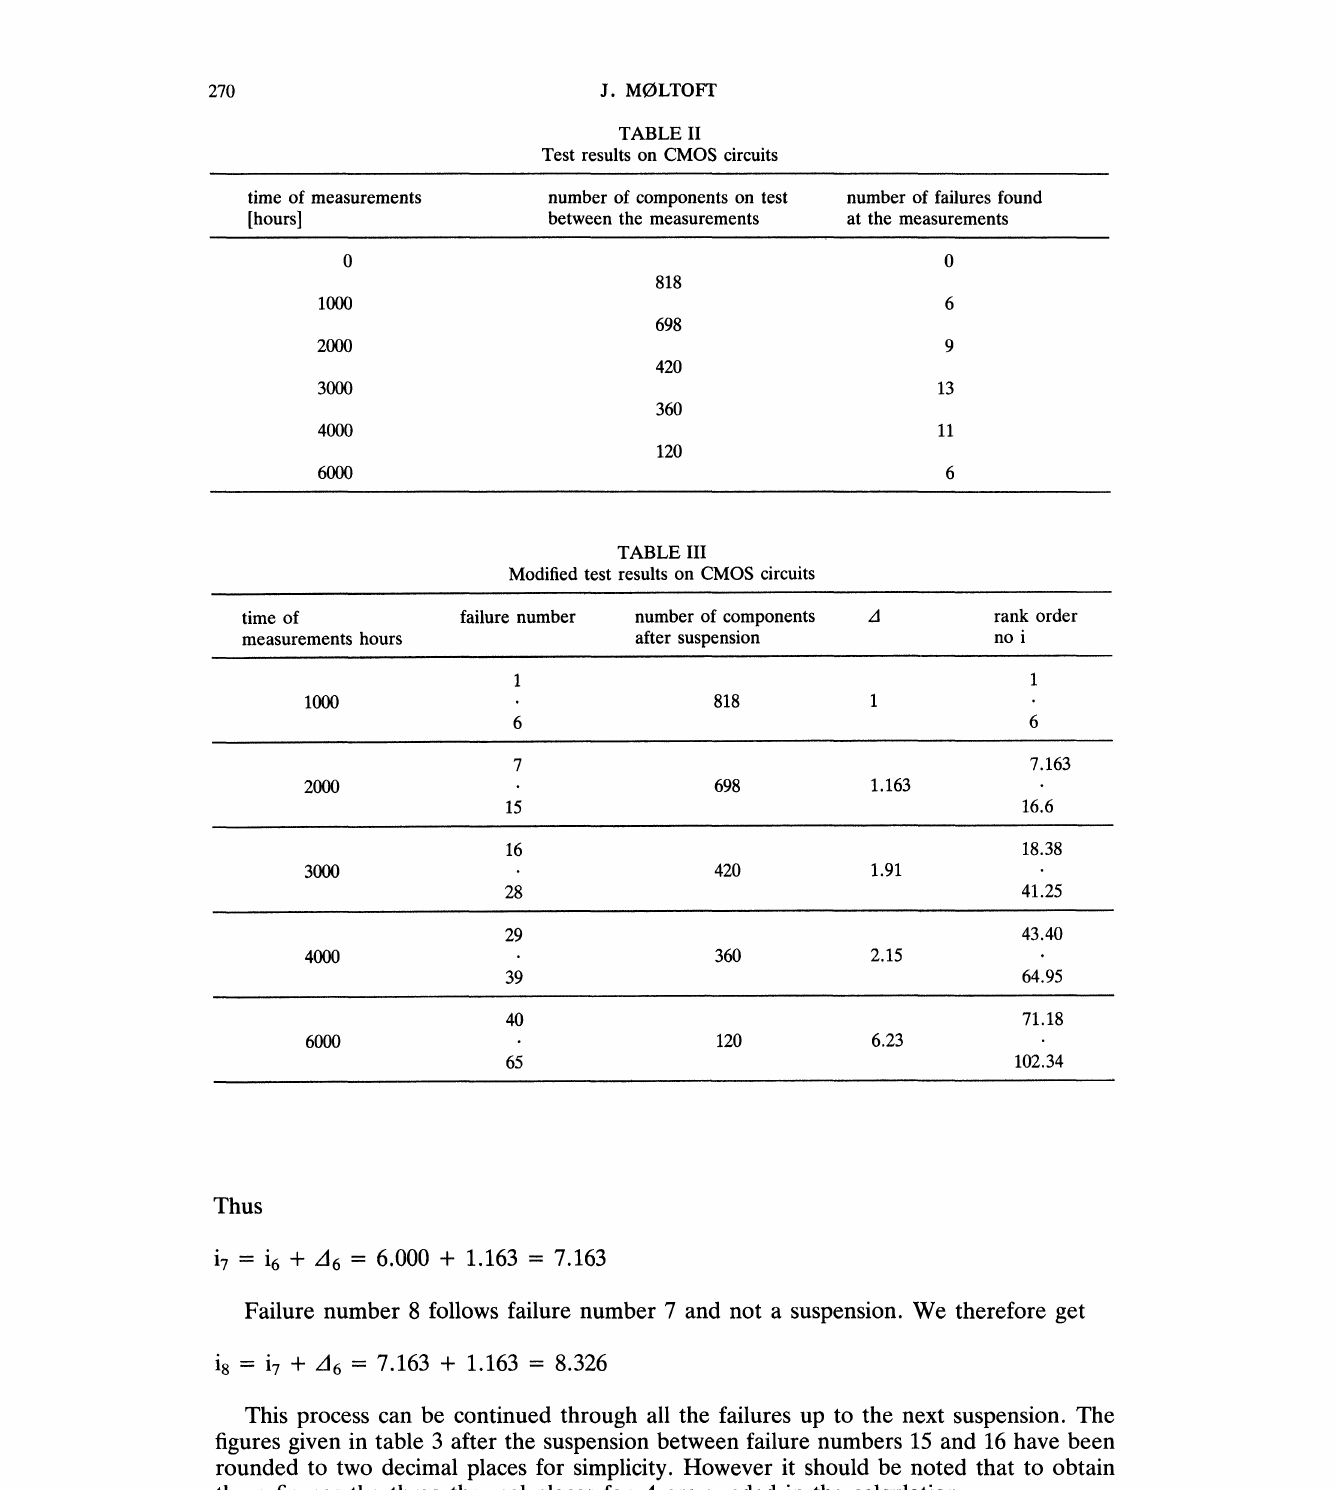
TABLE II Test results on CMOS circuits